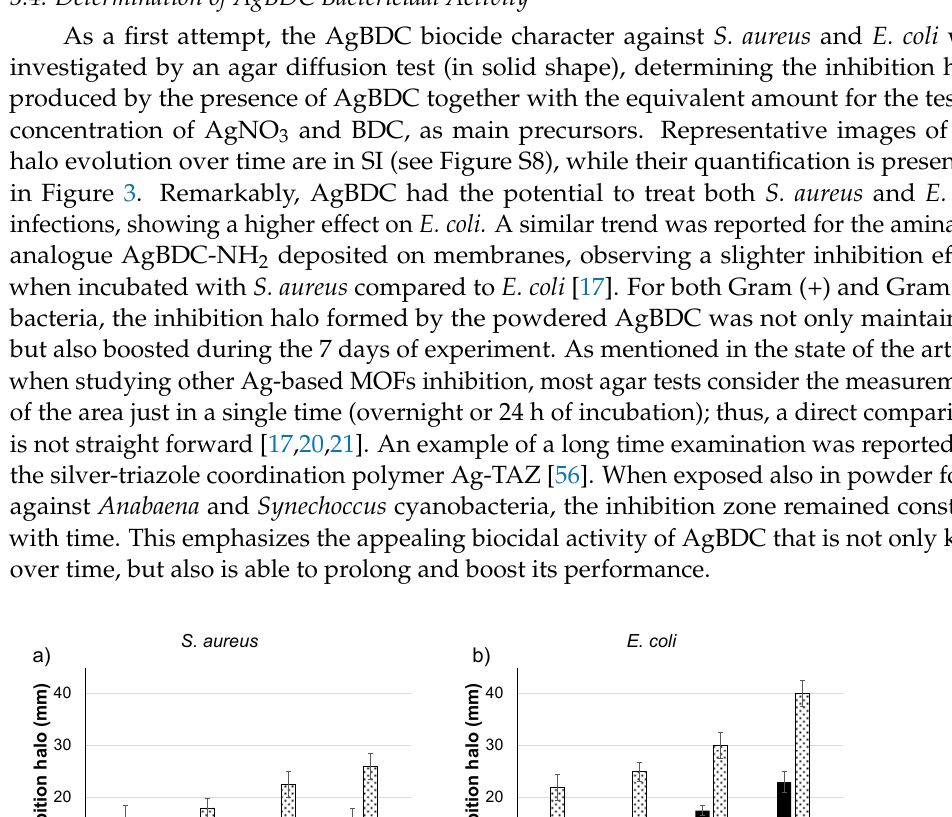
Figure 2. Degradation kinetics of AgBDC thin-film coating incubated in NB at 37 °C.